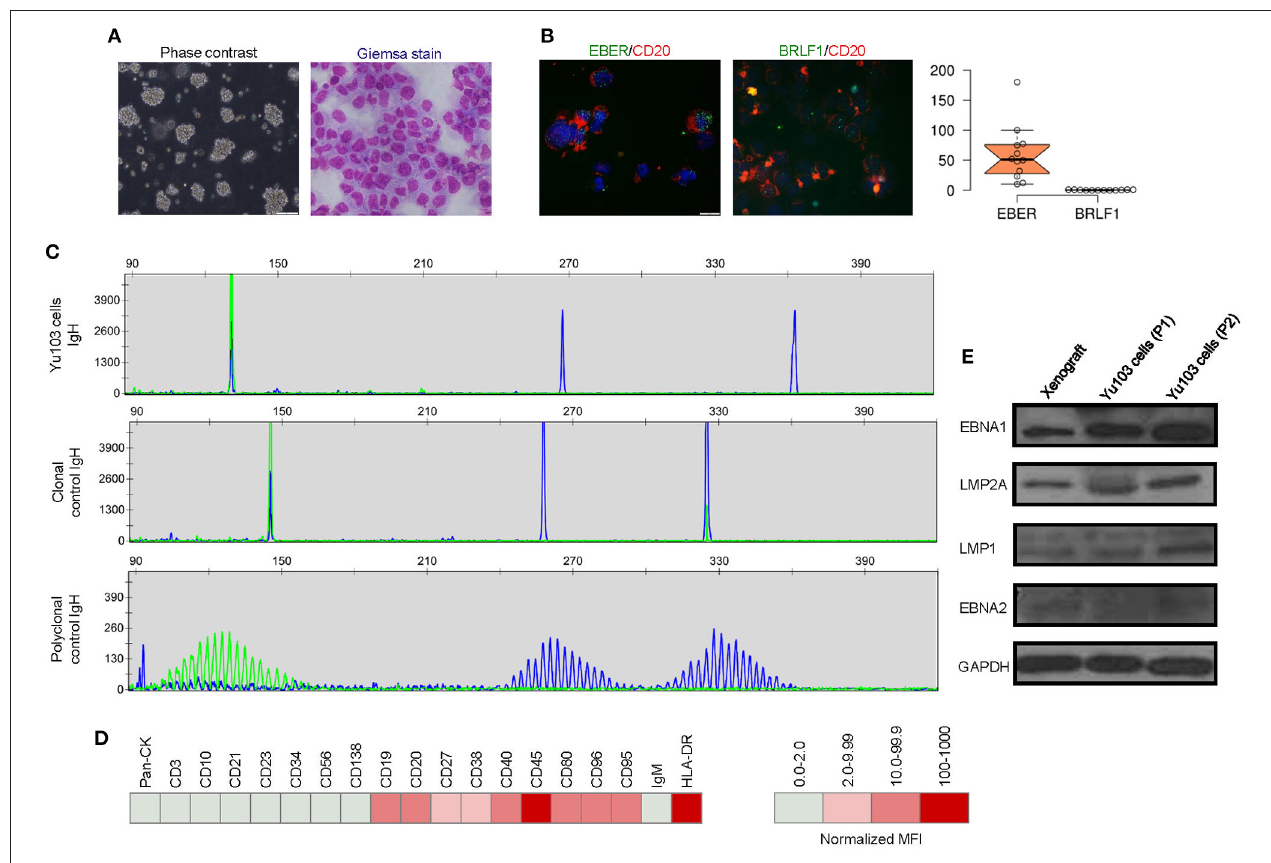
FIGURE 3 | Molecular characterization of the Yu103 cell line. (A) Yu103 cells growing in free-floating clusters, and Wright-Giemsa staining shows large B-lymphocytes with visible nucleoli in the cytospin cell preparation. (B) Co-staining by immunocytochemistry of CD20 and in situ hybridization of EBER or BRLF1 in Yu103 cells. The cell nuclei were counterstained with DAPI (blue). Quantitative estimates of EBV RNA puncta were plotted. (C) Yu103 cells were confirmed to be of monoclonal origin by PCR analysis of IgH gene rearrangements, which yielded single bands for the IgH genes centered around 130, 267, and 362 bp, respectively. The middle and lower panels show IgH analysis of monoclonal and polyclonal controls. (D) Fluorescence-activated cell sorting analysis and quantitative analysis of cell surface markers of Yu103 cells. (E) Western blot analysis of EBV latent gene products in parental xenograft tissues and passaged Yu103 cells (loading control: